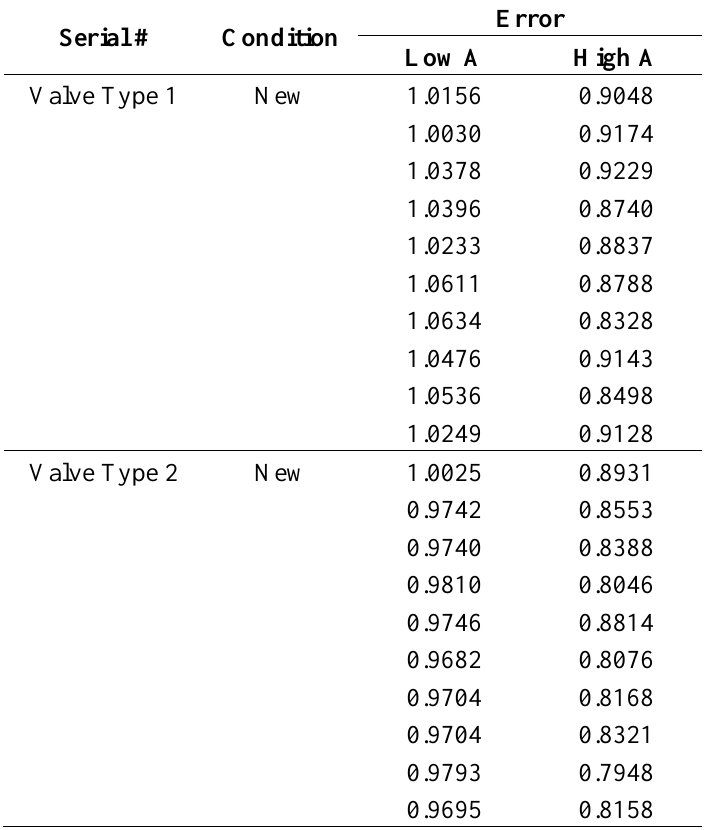
Table I. Results of